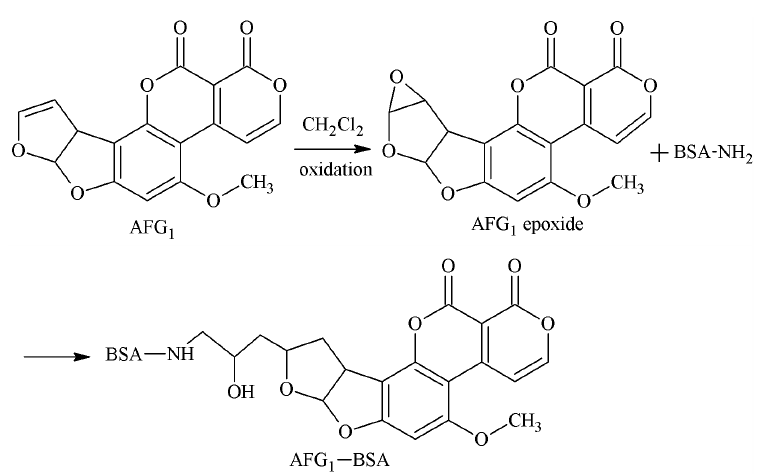
Figure 10. Synthesis of the AFG1-BSA antigen by the EP method.